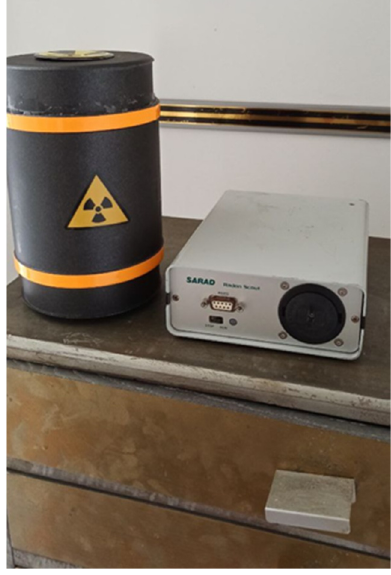
Figure 2. Measuring devices. Source: photo by author.